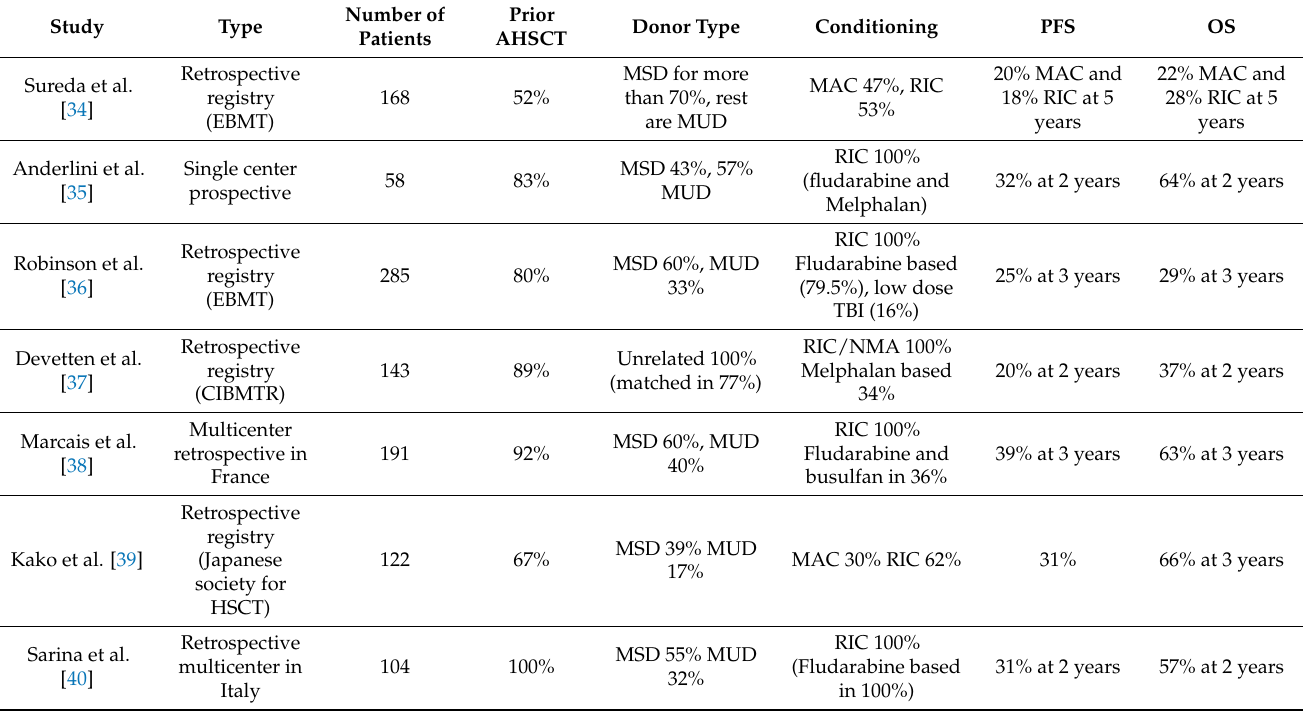
Table 1. Summary of the key studies evaluating the role of AlloHSCT in